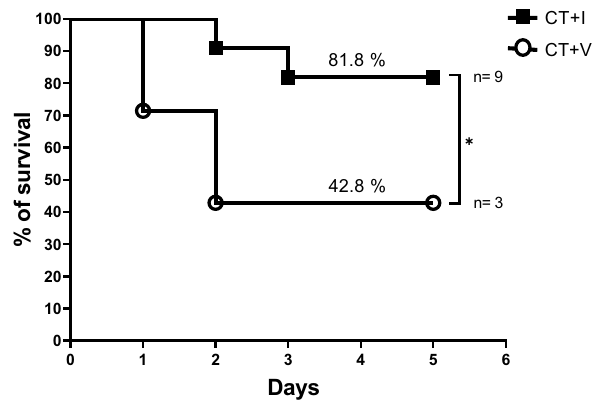
Figure 1. Effect of the immunomodulator on the survival of puppies affected by CPE. Puppies were daily administered with 0.5 mg of the immunomodulator showed an increase in survival (%) vs CT + V group. The initial number of puppies in the CT + V group was 7, and 4 died. The initial number of puppies in the CT + I group was 11, and only 2 died. The difference in survival percentage was 39.0%. Kaplan–Meier test and Gehan- Breslow-Wilcoxon post-hoc test were carried out. *P ≤ 0.05. CT conventional treatment, I immunomodulatory, V vehicle.